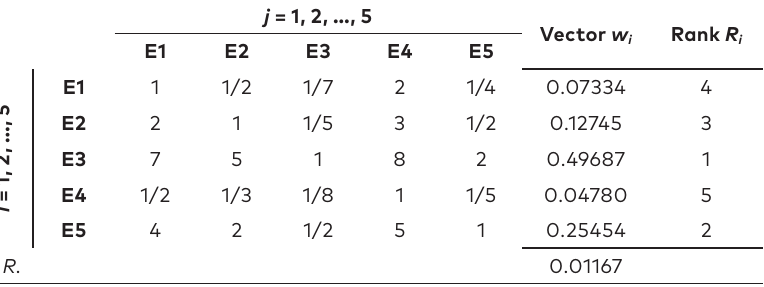
Table 6. An expert-completed pairwise comparison matrix and calculation